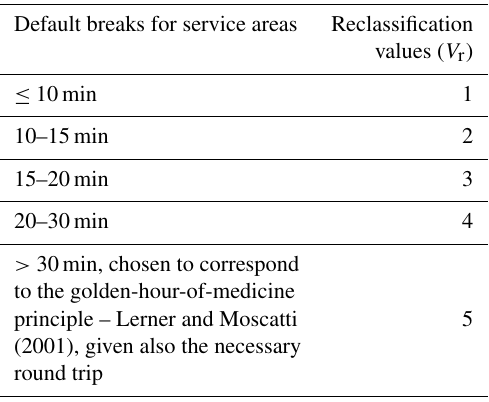
Table 3. Reclassification intervals for service area